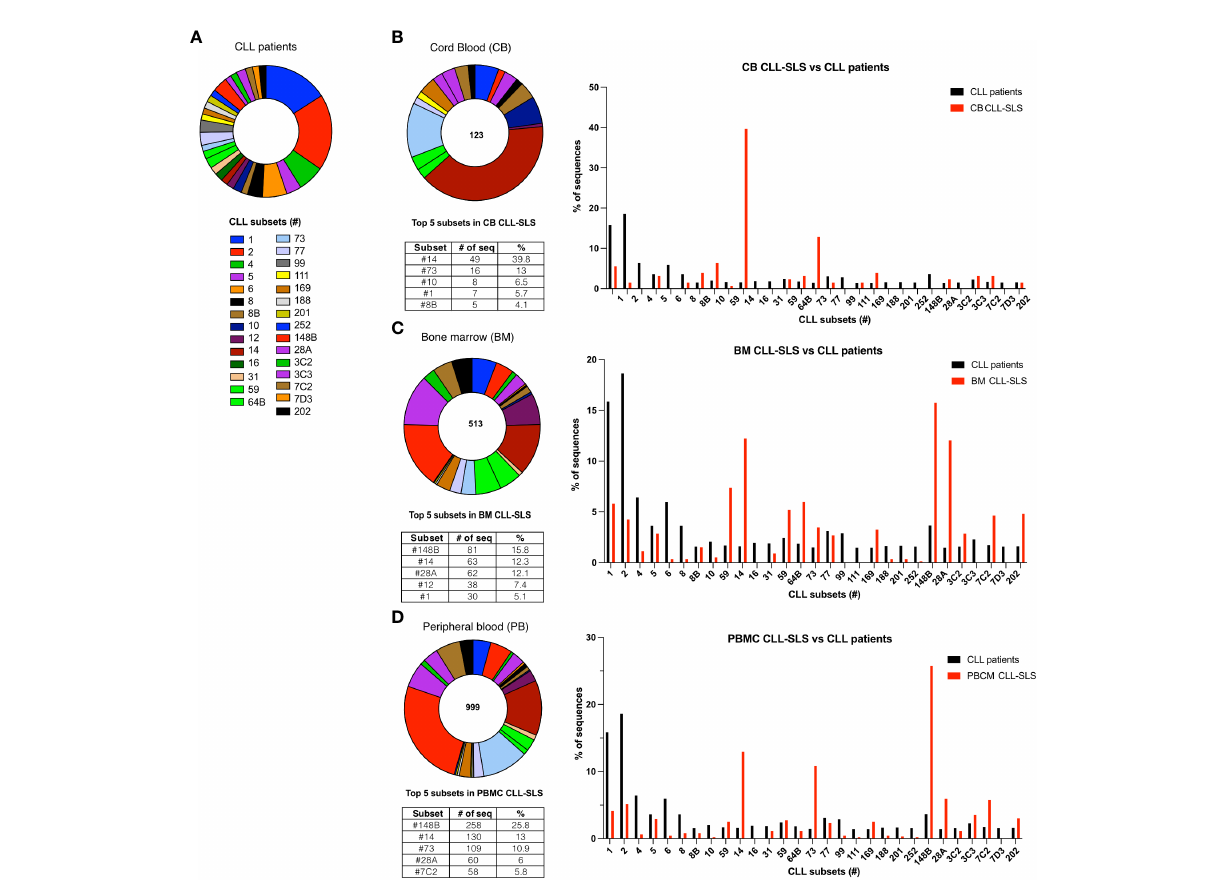
FIGURE 3 (A) Frequency distribution of the 29 different major standard stereotyped subsets among CLL patients. Each pie slice identi fi es a speci fi c subset in a different color. (B) Left panel: Frequency distribution of the standard CLL-SLS in the CB. Each pie slice identi fi es a speci fi c subset following color code in (A) Table below the chart indicates the top 5 most frequently found standard CLL-SLS. Right panel: Comparison of the frequencies of major CLL stereotyped subsets in patients and in CLL-SLS from CB. (C) Left panel: Frequency distribution of the standard CLL-SLS in the BM. Right panel: Comparison between the frequencies of major CLL stereotyped subsets in patients and in CLL-SLS from BM. (D) Left panel: Frequency distribution of the standard CLL-SLS in the PBMC. Right panel: Comparison of the frequencies of major CLL stereotyped subsets in patients and in CLL-SLS from PBMC.